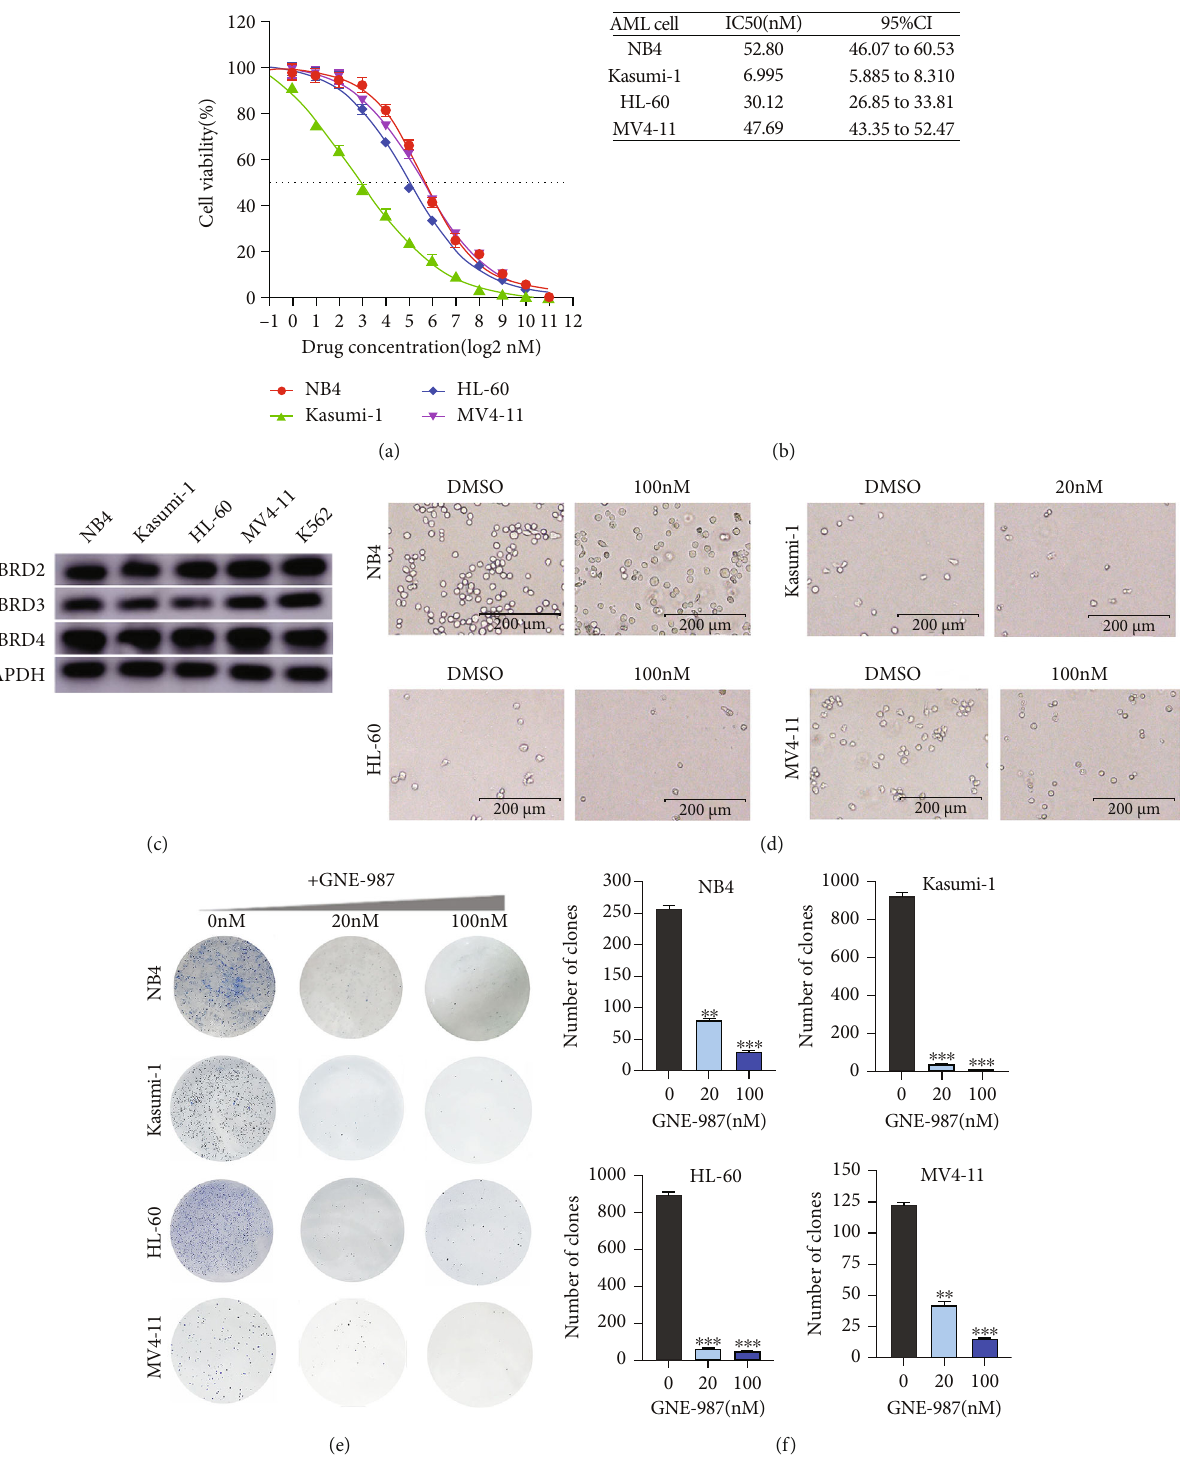
Figure 2: GNE-987 can cause the death of AML cell lines and inhibit their growth. (a) Cell viability curve after adding di ff erent concentration gradients of GNE-987 to NB4, Kasumi-1, HL-60, and MV4-11 cell lines. (b) IC50 values of GNE-987 with di ff erent concentration gradients were added to AML cells. (c) Basal BET protein level analysis in myeloid cell lines NB4, Kasumi-1, HL-60, MV4-11, and K562. (d) Fluorescence microscope photos of AML cell lines NB4, Kasumi-1, HL-60, and MV4-11 24 hours after adding GNE-987. (e) Number of AML cell clones added with di ff erent concentrations of GNE-987. (f) Statistical histogram of the number of AML cell clones added with di ff erent concentrations of